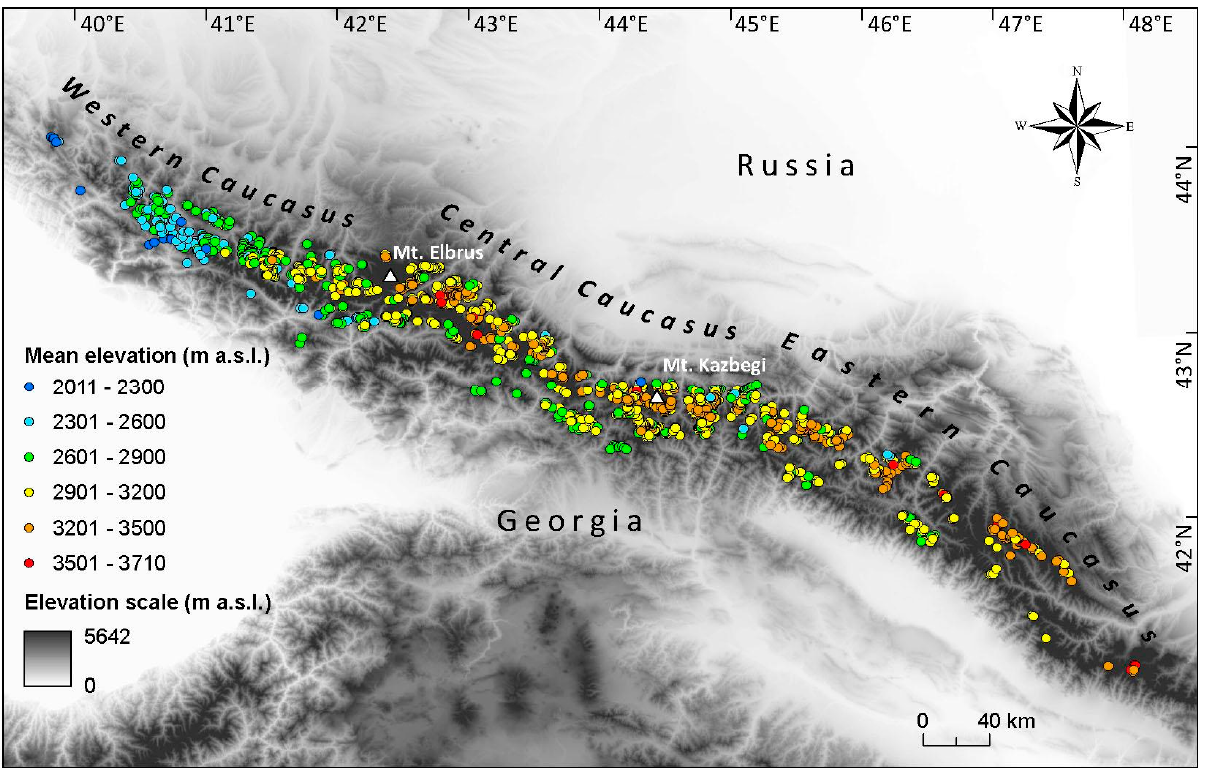
Figure 7. Color-coded map of mean elevation for all rock glaciers larger than 0.01 km 2 in the Greater Caucasus.